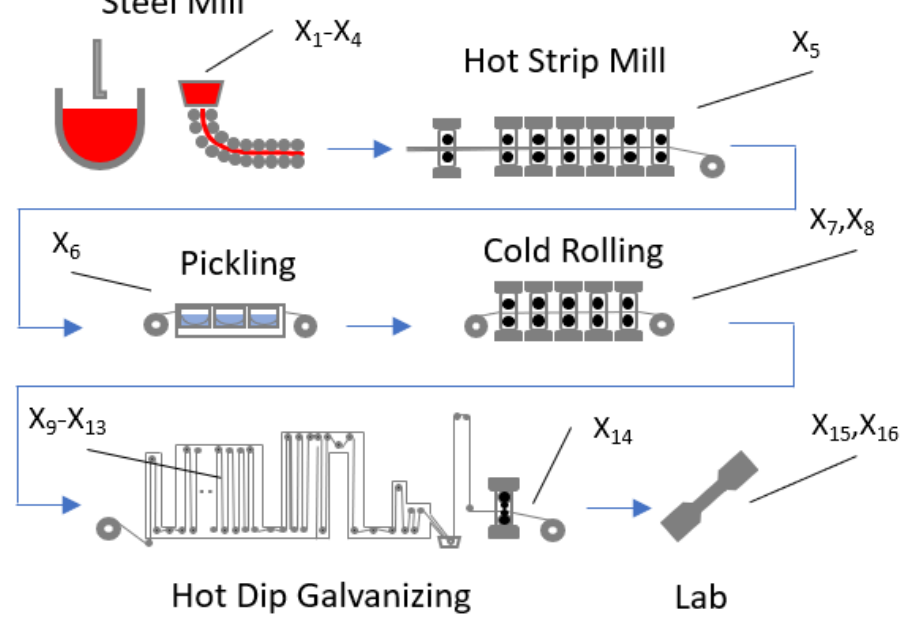
Figure 2. Stages of the process.